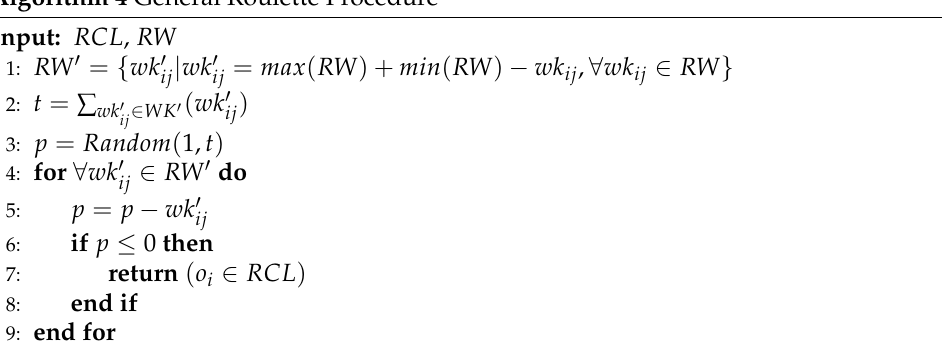
Algorithm 4 General Roulette